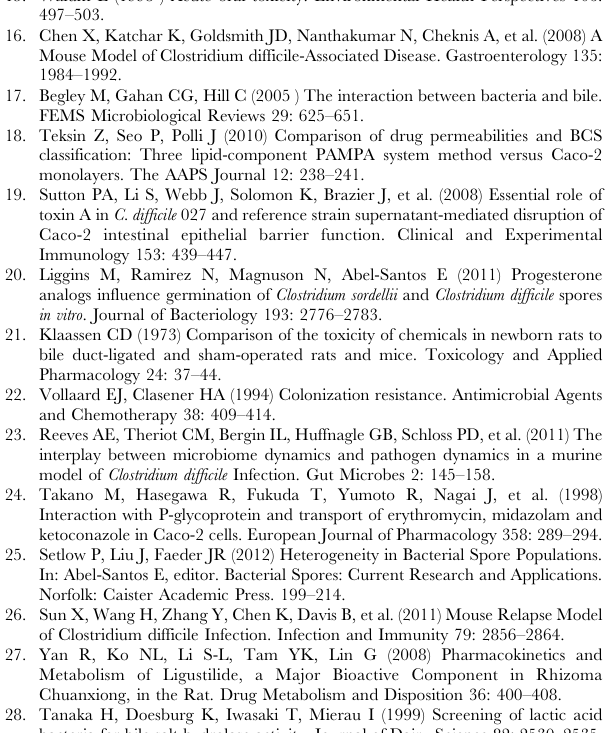
DMSO ( e ), 300 mg/kg taurocholate ( D ), 50 mg/kg chenodeox-